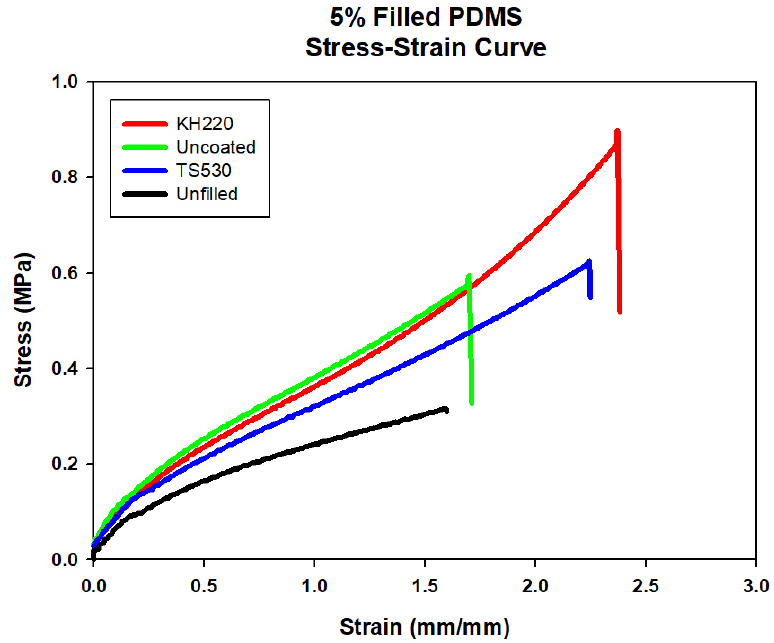
Figure 5. Stress–strain Curve of Unfilled and 5% Filled PDMS with Three Filler Types.